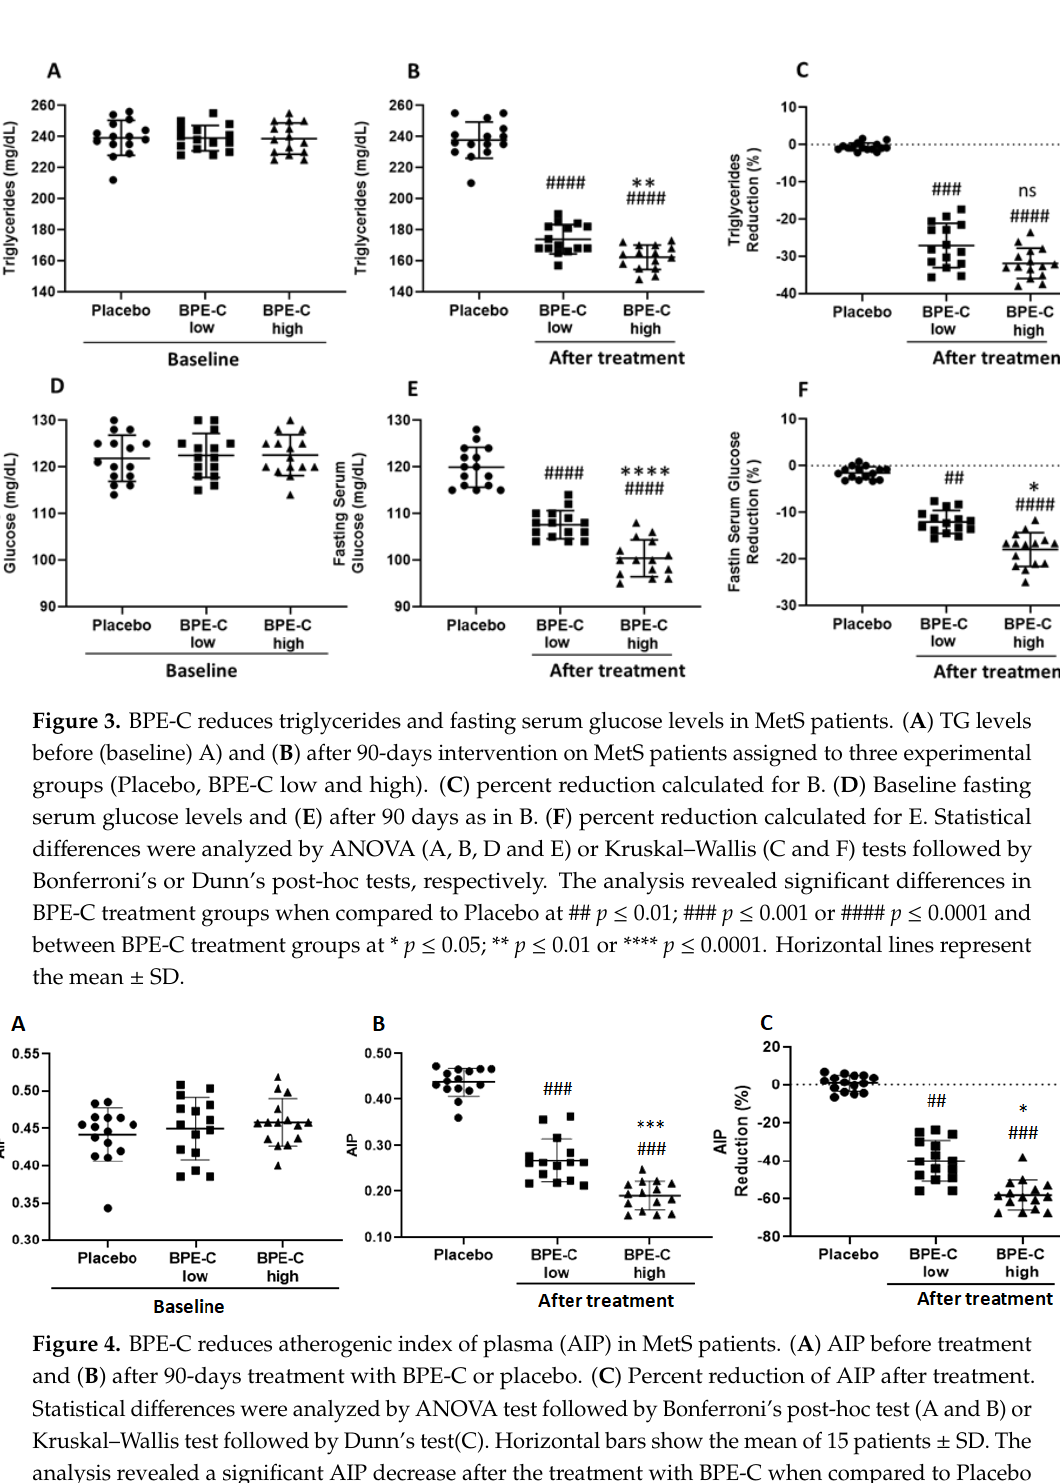
Figure 4. BPE-C reduces atherogenic index of plasma (AIP) in MetS patients. ( A ) AIP before treatment and ( B ) after 90-days treatment with BPE-C or placebo. ( C ) Percent reduction of AIP after treatment. Statistical di ff erences were analyzed by ANOVA test followed by Bonferroni’s post-hoc test (A and B) or Kruskal–Wallis test followed by Dunn’s test(C). Horizontal bars show the mean of 15 patients ± SD. The analysis revealed a significant AIP decrease after the treatment with BPE-C when compared to Placebo at ## p ≤ 0.01 or ### p ≤ 0.001 for both doses of BPE-C. The response to BPE-C was dose-dependent at *** p ≤ 0.001 (B) or at * p ≤ 0.05, when % reductions were compared (C).